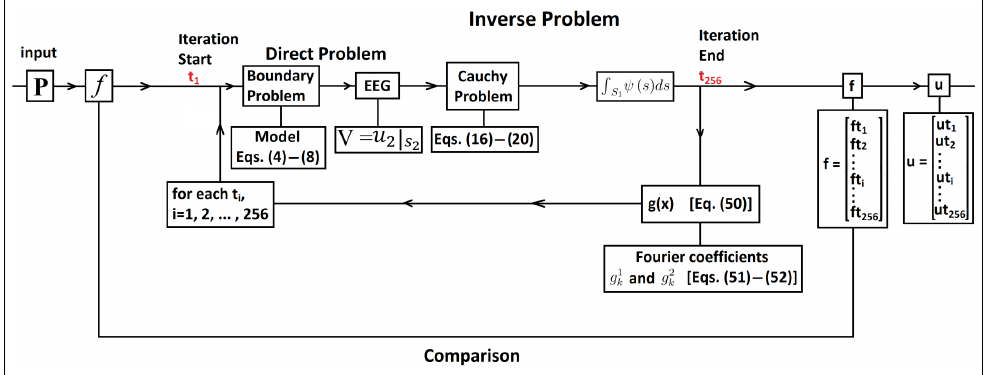
Figure 4. Algorithm of the proposal in this work, for optimizing the computation times by simplifying the direct problem having an inverse problem solution that allows us to determine the source function and the solution at different times. The algorithm is iterative, with i the number of iterations, depending on the number of points or divisions equal to 64, 128, 256, 512 in the time interval t = [ 0,1 ] . The comparison was performed according to the COMSOL problem construction to generate the Matlab code, starting from the geometry construction, the regions or region (due to the problem simplification), boundary conditions, and the mesh quantification in the finite element method.